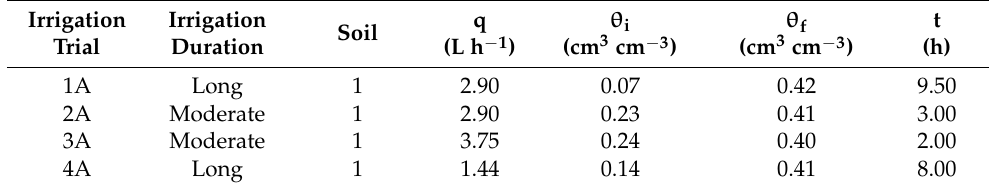
Table 3. Characteristics of the moderate- and long-duration irrigations of the first experimental block.